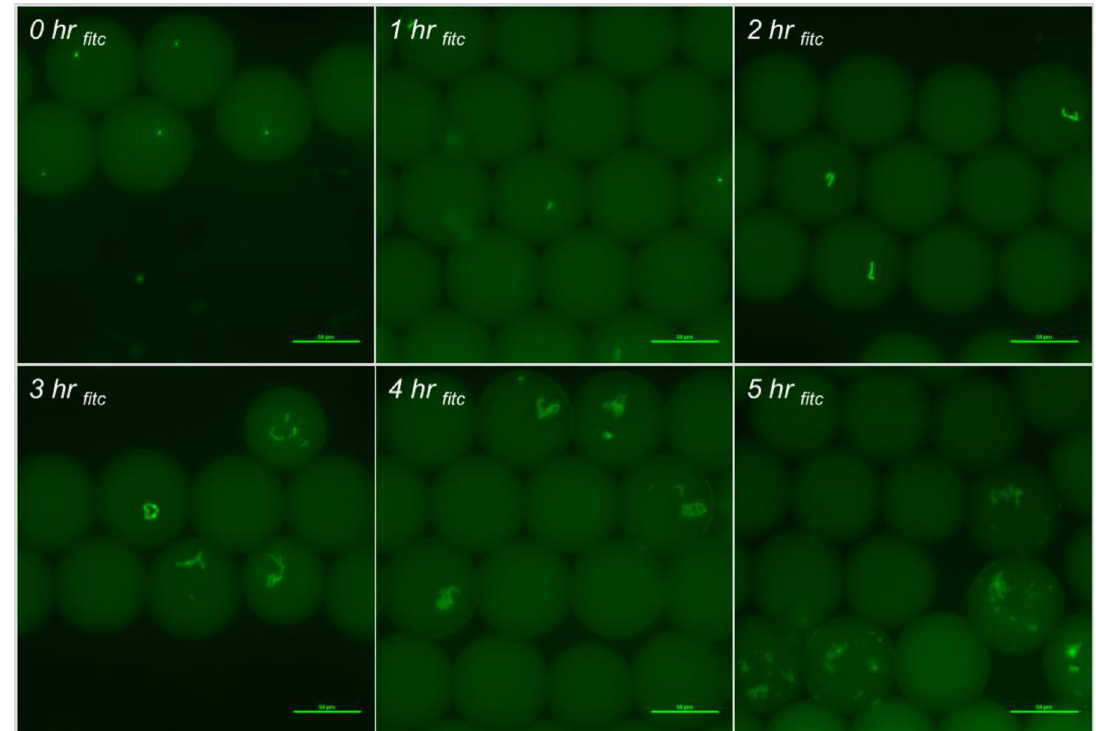
Fig 5. Fluorescent images of S . Typhimurium incubation in-droplet with sterile deionized water, and 10 μ g/ml FITC-Ab in 1x RV broth at 37˚C.